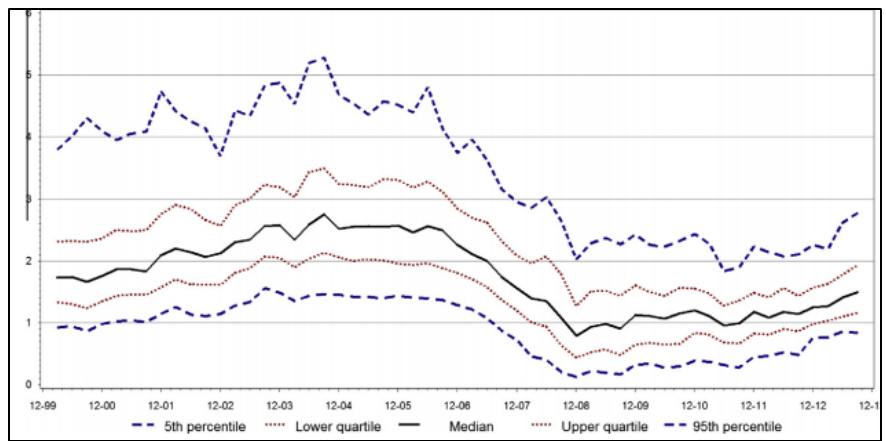
Figure 1: Trend of market-to-book ratio of large, publicly listed US bank holdings The study of Massari, Gianfrate, & Zanetti (2014) offered a type of approach that can be used in the final valuation of banks in which each business that the banks have will be valued separately, then summed up to form the bank’s final valuation. The commercial banking arm can be valued using the income approach of discounted cash flow to equity [DCFE]; investment banking can be valued using relative valuation such as price-earnings [P/E] multiple; and asset management using price-asset under management [P/AUM] valuation (Massari et al.,